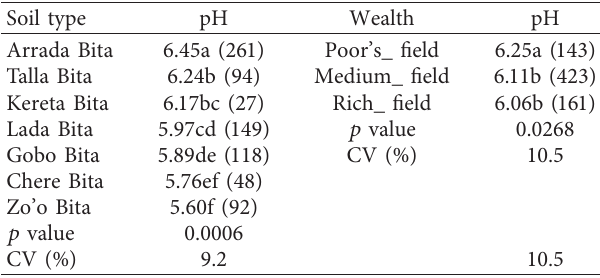
Table 5: Field position and cropping intensity effects on the mean value of soil pH ( N � 789).